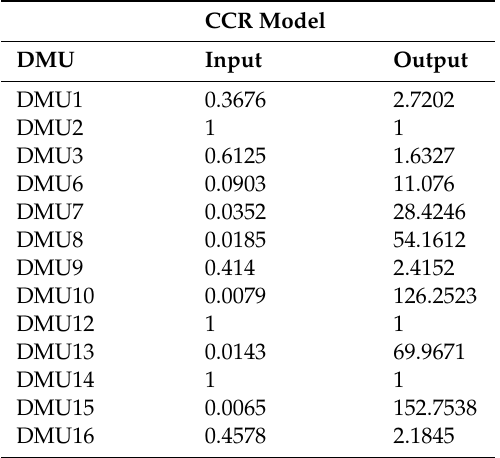
Table 5. CCR method for assessing the e ff ectiveness of textile and clothing